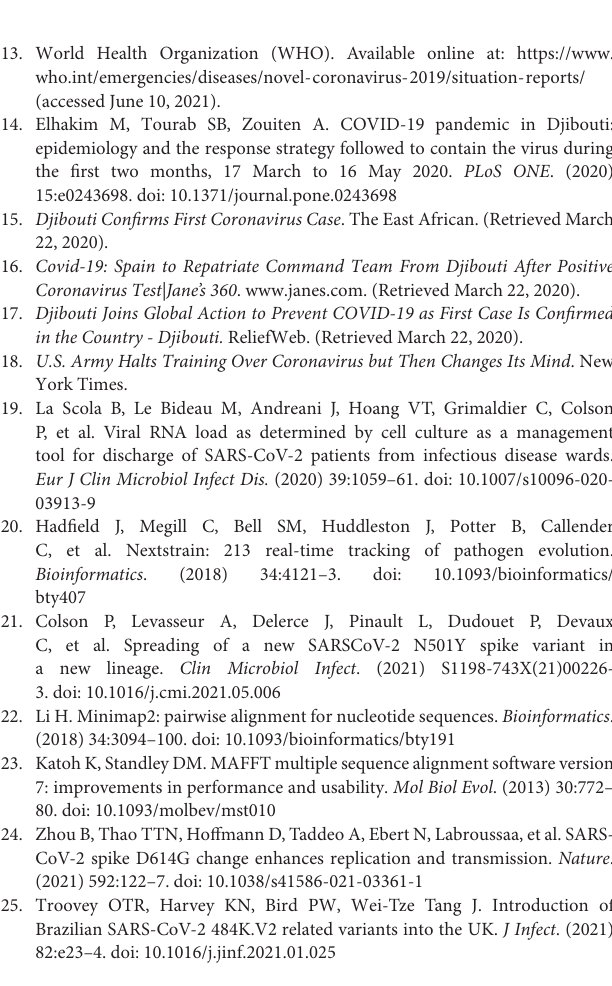
Supplementary Figure 1 | Phylogenetic tree (obtained using the IQ-TREE software with the GTR Model and 1,000 ultrafast bootstrap 84 repetitions), including SARS-CoV-2 genomes from the COVID-19 Djiboutian patients reported herein (Djibouti/CNSS00XXX-IHU103XXXXXXX/2020 for samples collected in 2020 and Djibouti/CNSS1XXX-IHU103XXXXXXX/2021 for samples collected in 2020; Djibouti/CNSS00XXX: the number XXX can be found in Table 2 ) compared to the 52 sequences of SARS-CoV-2 spread during the second epidemic wave among members of the US department of Defense in Djibouti (GISAID ID: Djibouti/NAMRU3-XXXX/2021) and several other strains chosen to strengthen the organization of the phylogenetic tree. Supplementary Table 1 | qRT-PCR primers and